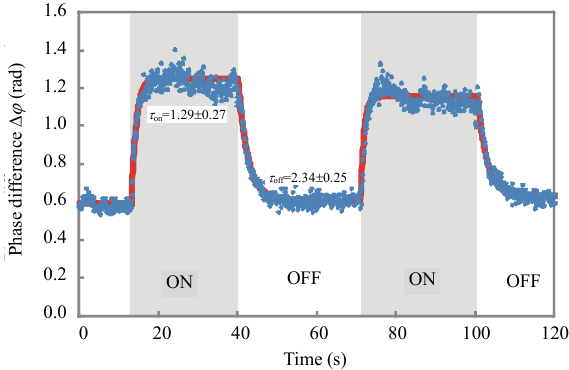
Fig. 4 Measured sensor comprising a waveguide with 1.2 μ m thick organic glass PMMA + DMABI-Ph6 cladding response to the gas stream flowing on the sample in time, where the OFF state corresponds to pure N 2 stream, while the ON state to the mixed IPA / N 2 stream.